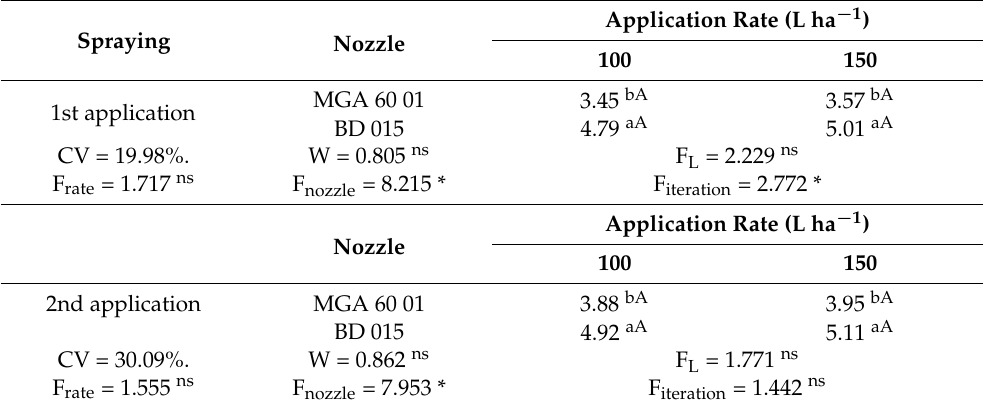
Table 4. Average values of droplet deposition ( µ g cm − 2 ) on the leaves of coffee seedlings after spraying with the sunscreen on the leaves of conilon coffee seedlings on the 7th (1st) and 30th (2nd) days after planting in pots in the